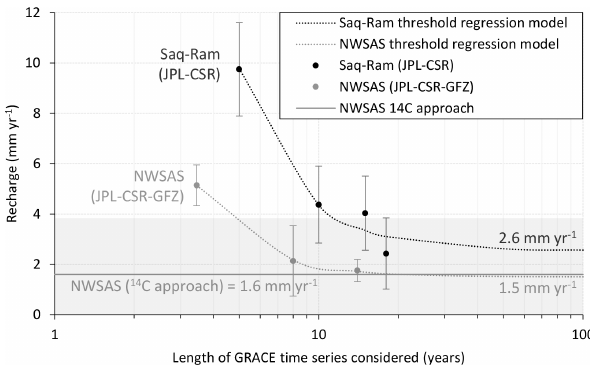
Figure 7. Changes in recharge rate and associated error bars con- sidering different lengths of GRACE time series for the Saq–Ram Aquifer System compared to the NWSAS recharge rates obtained by GRACE and 14 C approaches ( 14 C uncertainty as a grey square), and their associated threshold regression